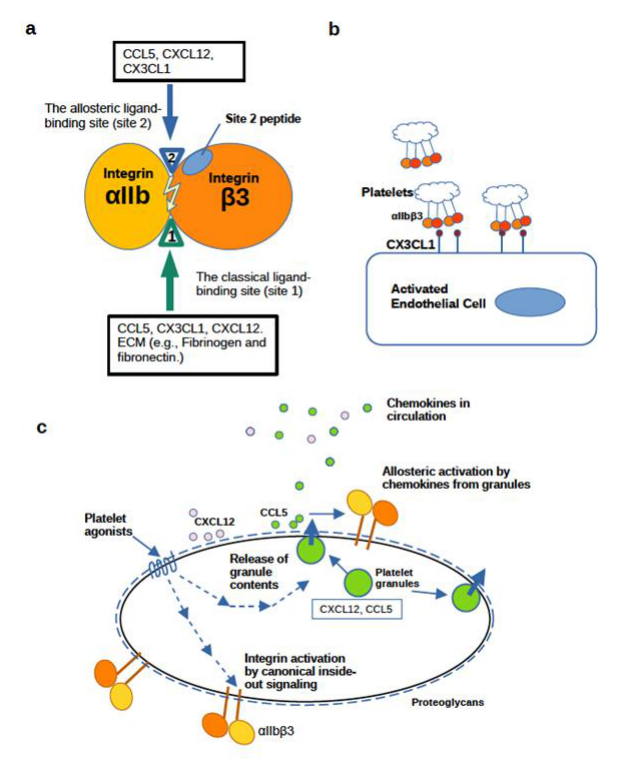
Figure 8. Possible biological role of allosteric activation of αIIbβ3 by CCL5, CXCL12, and CX3CL1. ( a ) A model of the binding of CCL5, CXCL12, and CX3CL1 to the classical ligand binding site (site 1) and to the allosteric site (site 2) in integrin αIIbβ3. CCL5, CXCL12, and CX3CL1 bind to site 1 and